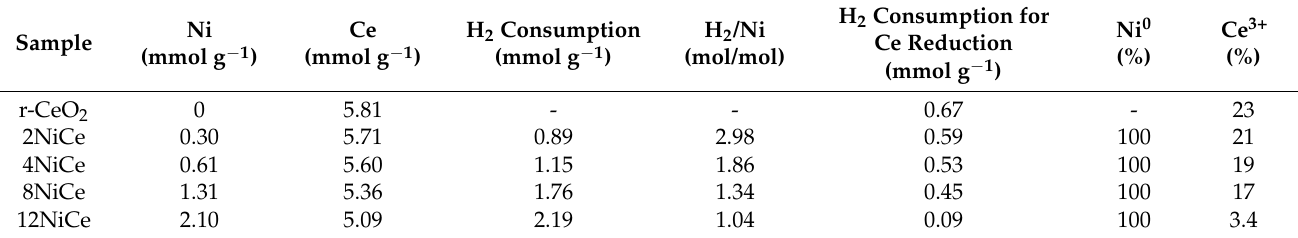
Table 2. NiO and CeO 2 reducibility up to 800 ◦